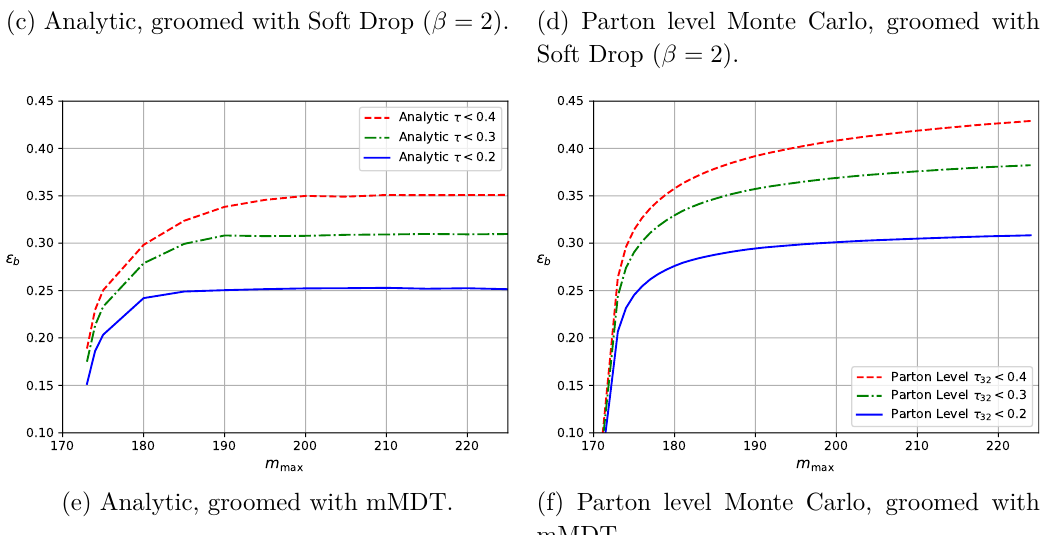
Figure 9. Analytic and Monte Carlo parton level curves showing how the signal tagging rate varies with m max